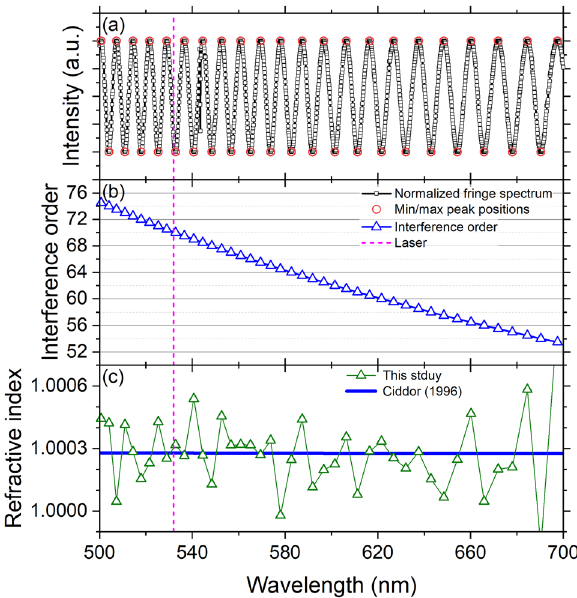
Figure 5. Dispersion of air. ( a ) Normalized spectrum (black square) in Fig. 3c with marks at the peaks (red circle). ( b ) Interference order at each peak (blue triangle) calculated with k L at (cid:31) L (pink dotted). ( c ) The obtained refractive index (green triangle) is compared with the literature data 33 (thick blue